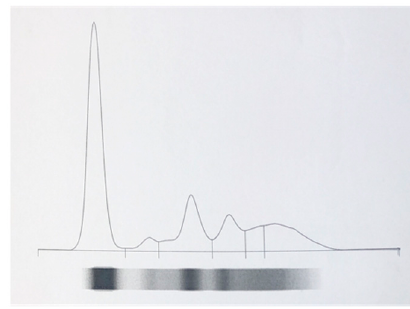
Figure 1. Electrophoretic curve of one healthy tiger. Agarose gel electrophoresis was able to separate serum proteins into six fractions: albumin, α 1, α 2, β 1, β 2 and γ globulin in order of decreasing anodal mobility.